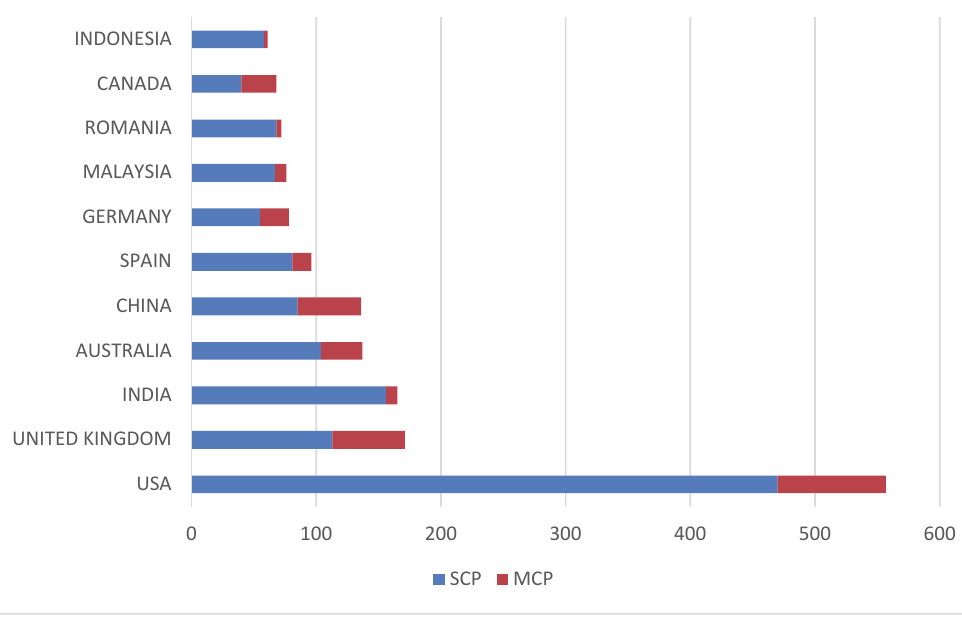
Fig. 4. Corresponding Author's Country